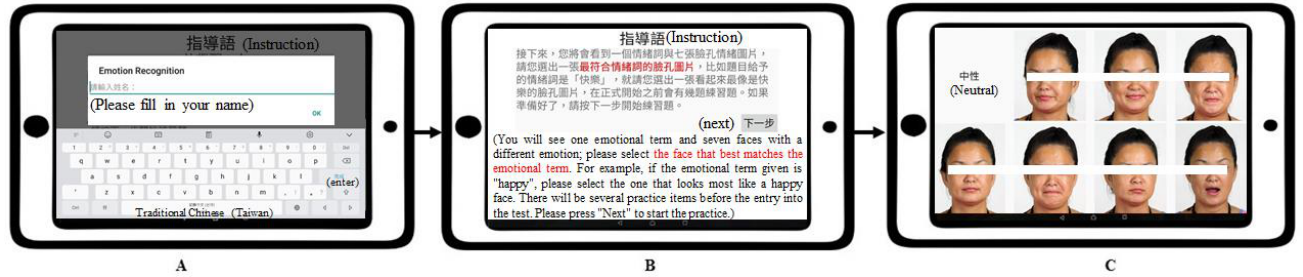
Figure 1. The diagrammatic sketch of the MMER app, taking subtest four as an example. ( A ) The step in which the participant’s information was entered; ( B ) the step to show the participants the instructions; ( C ) the step where the participant was asked to choose the correct answer.